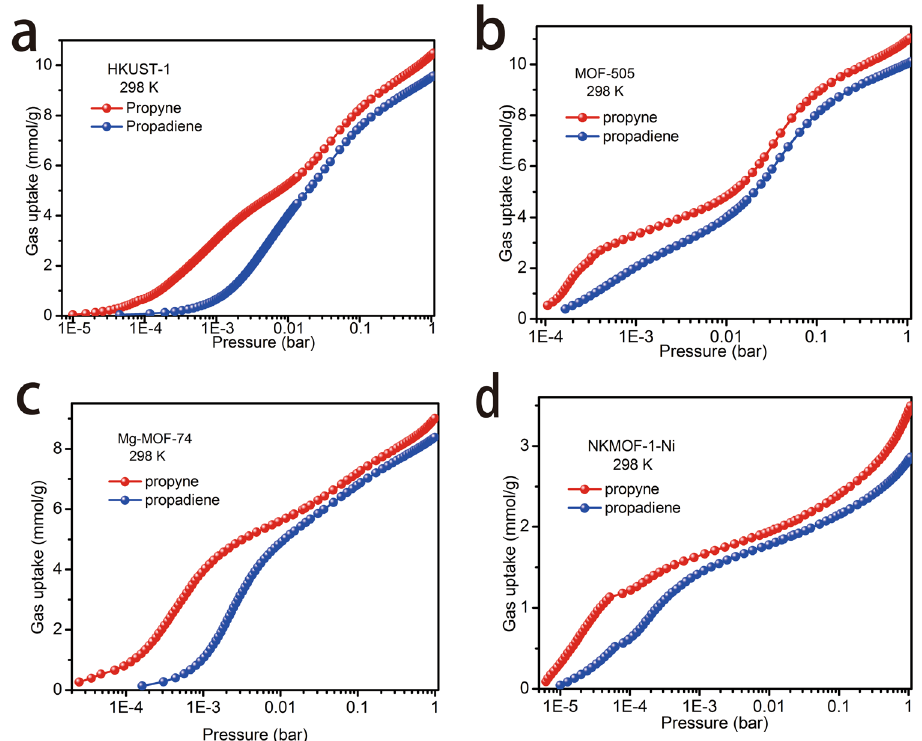
Fig. 5 Propyne and propadiene equilibrium adsorption isotherms of the selected MOF materials at 298 K. a HKUST-1. b MOF-505. c Mg-MOF-74. d NKMOF-1-Ni.